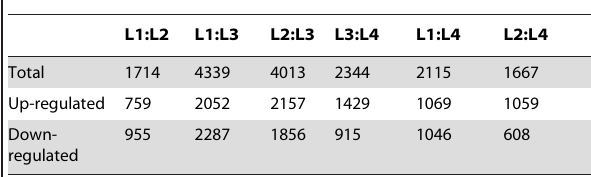
Table 3. DEGs across all